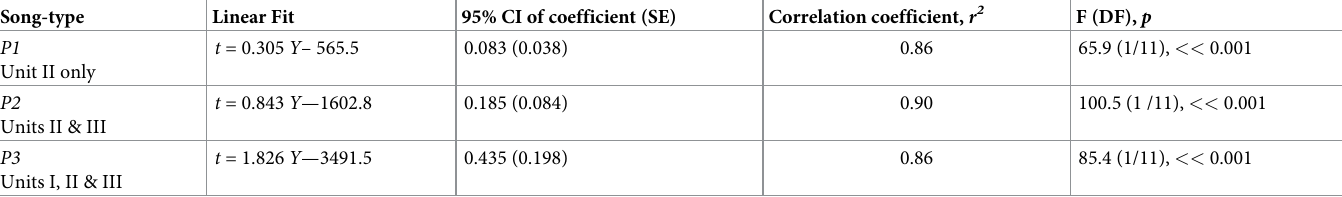
Table 3. Fitted curves to ISI-spacing across seasons for P1 , P2 and P3 songs (ISI-curve analysis). Song-type Linear Fit 95% CI of coefficient (SE) Correlation coefficient, r 2